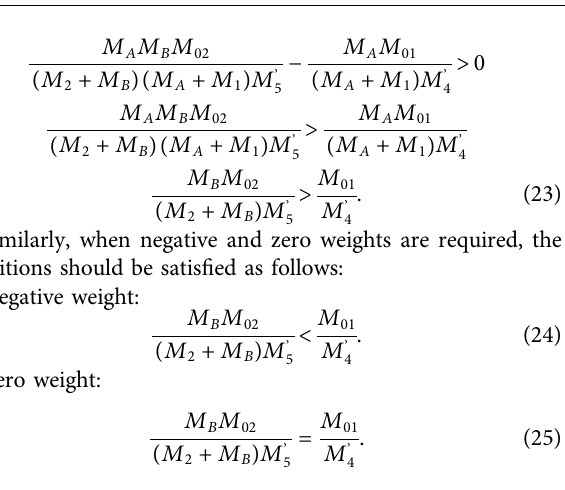
FIGURE9| In fl uenceofp onlinearity. (A) Timeneededfor M 5 initializationincreasedas p declined. (B) M 2 and (C) M 5 showsthatthelower p valueis,theslowerthe speed of memristor state transition. (D) Although the time of set weight increases, it still maintains good linearity.